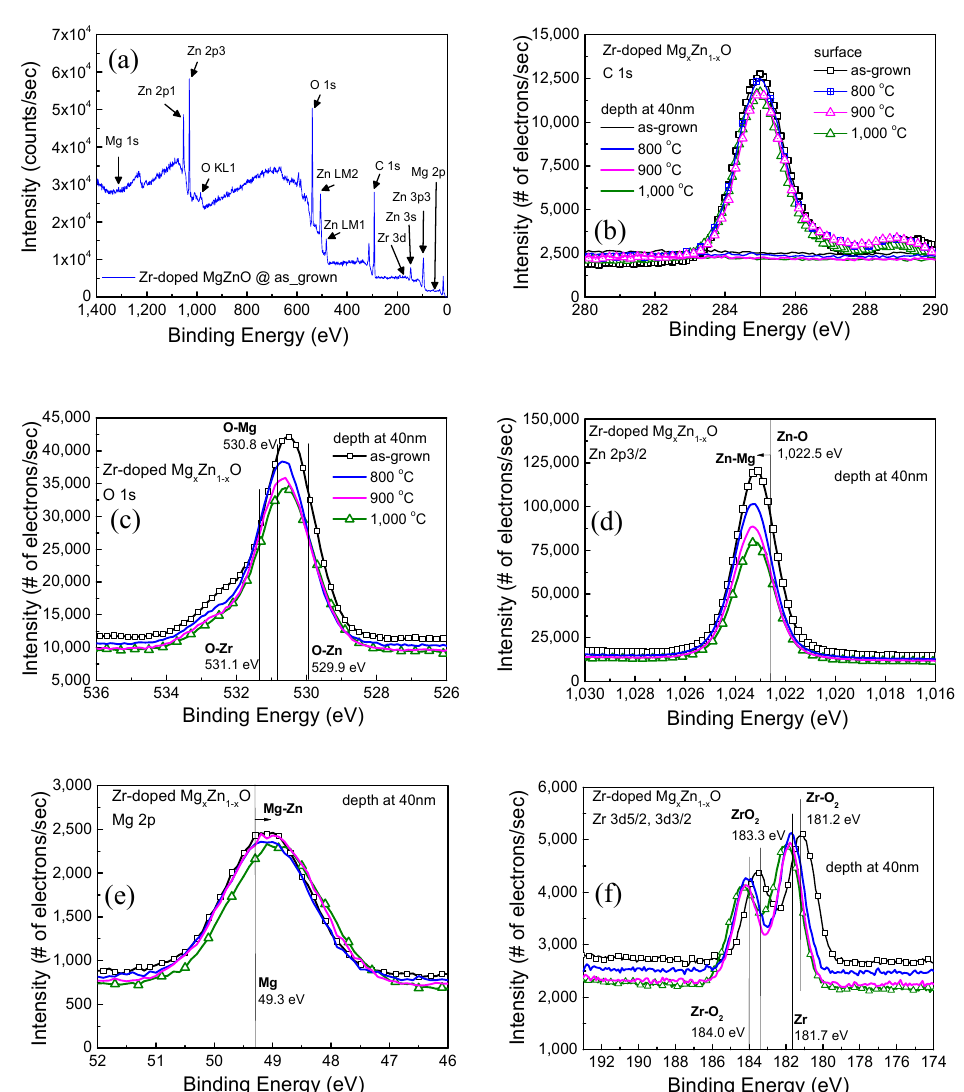
Figure 3. (Color Online) ( a ) X-ray photoelectron spectroscopy (XPS) spectrum of surface elements in the as-deposited Zr-doped MZO film. ( b ) C 1s, ( c ) O 1s, ( d ) Zn 2p3/2, ( e ) Mg 2p, and ( f ) Zr 3d XPS spectra of as-grown Zr-doped MZO films annealed at 800, 900, and 1000 ◦ C, with spectra obtained at the surface and at a depth of 40